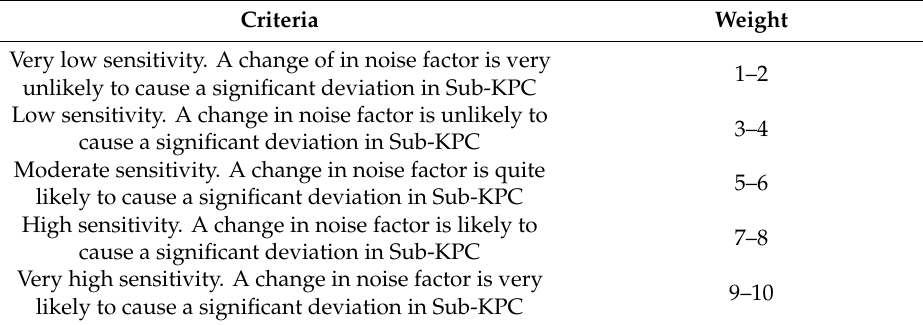
Table 5. Criteria for assessing the sensitivity of Sub-KPC to noise factors [32]. Criteria